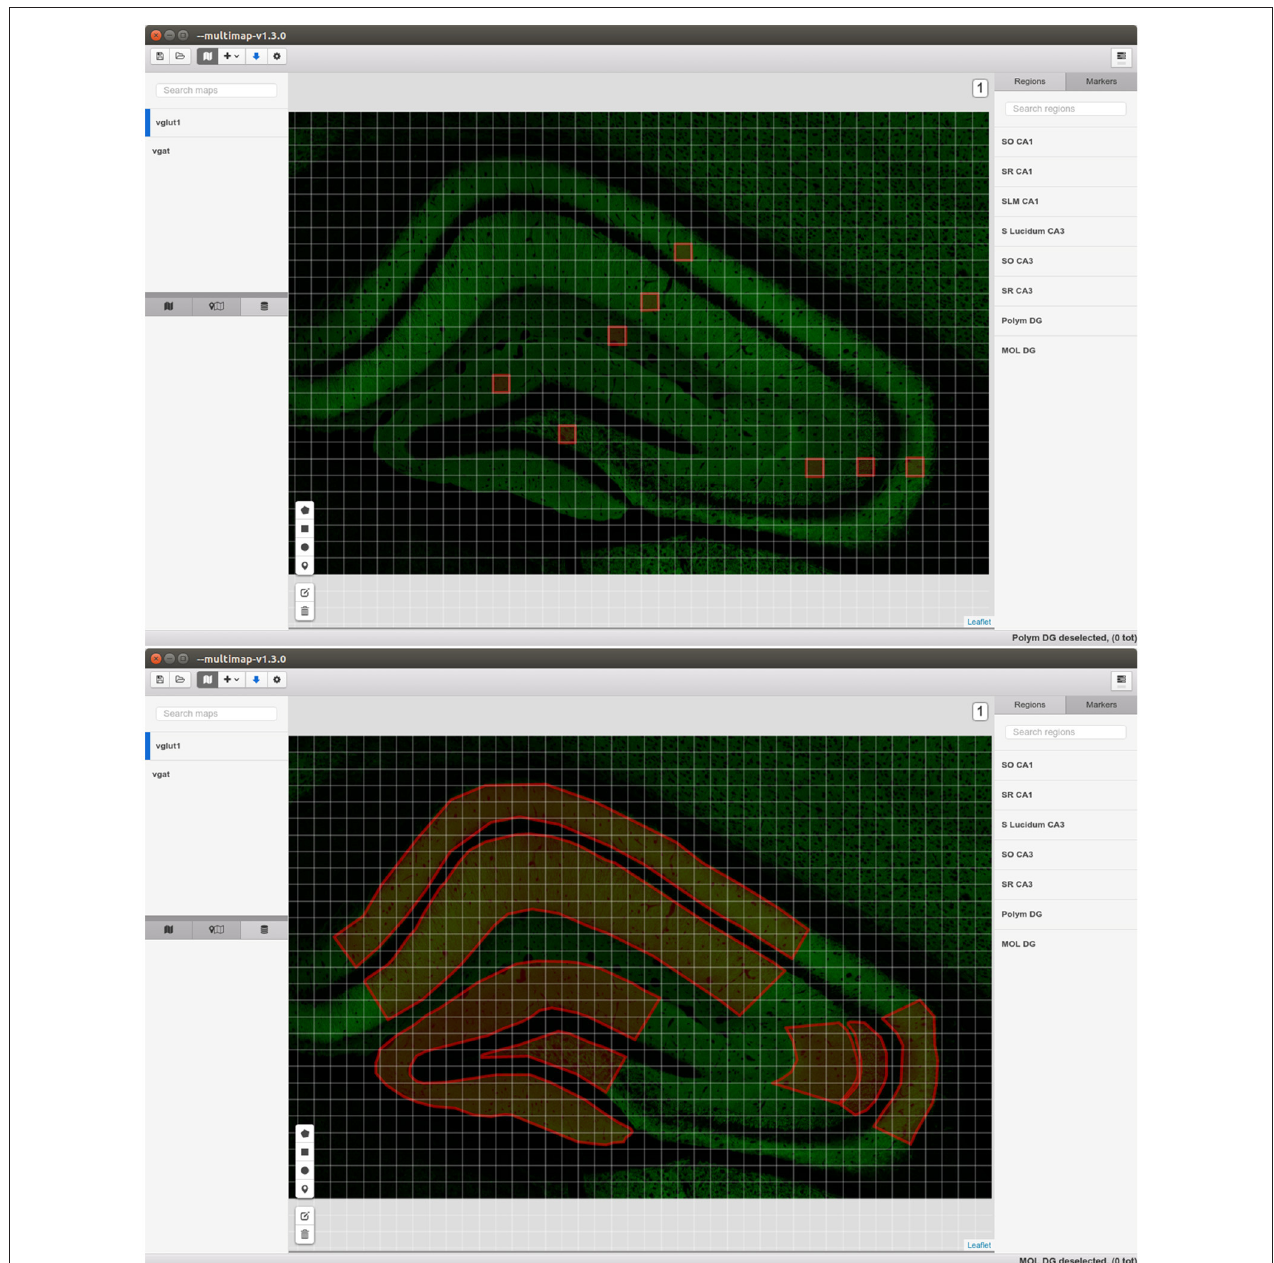
FIGURE 2 | Graphical Interface of